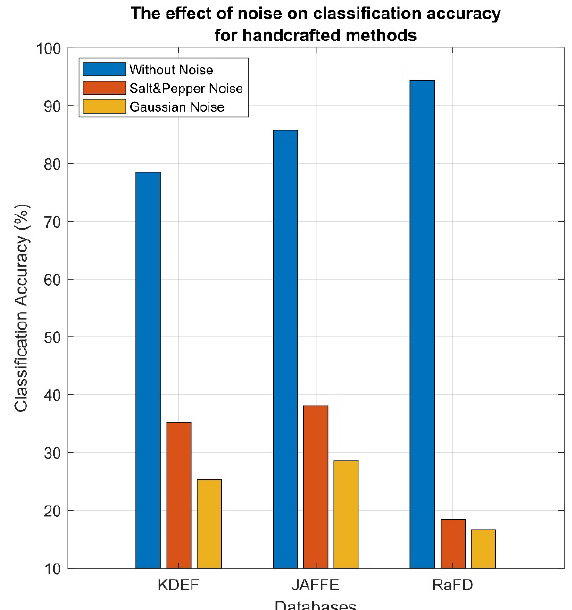
Figure 7. Classification accuracy for each database with handcrafted methods. The blue bar depicts the results on clear images, the red bar on images with salt and pepper noise, and the yellow bar on images with Gaussian noise. The training was performed in clear images.